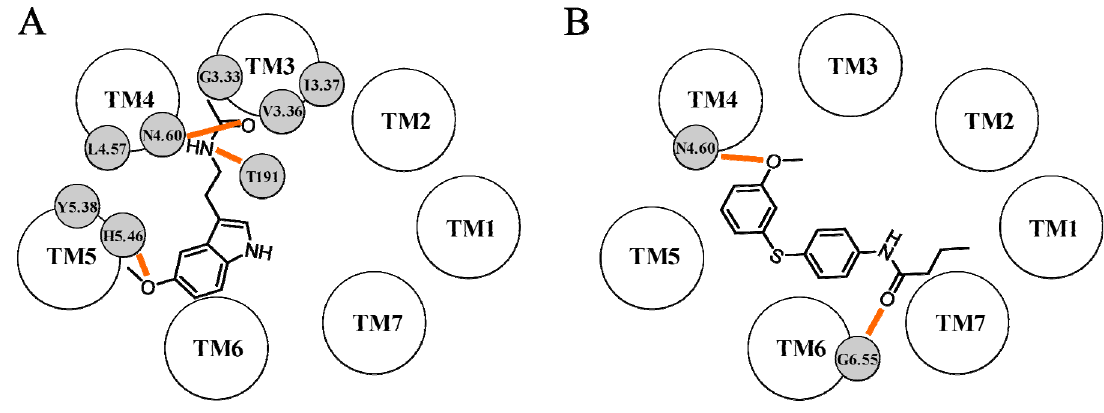
Figure 9. Schematic representation of the binding modes of melatonin ( A ) and of an anilide derivative ( B ) proposed by Farce et al. within the MT interactions are depicted with orange